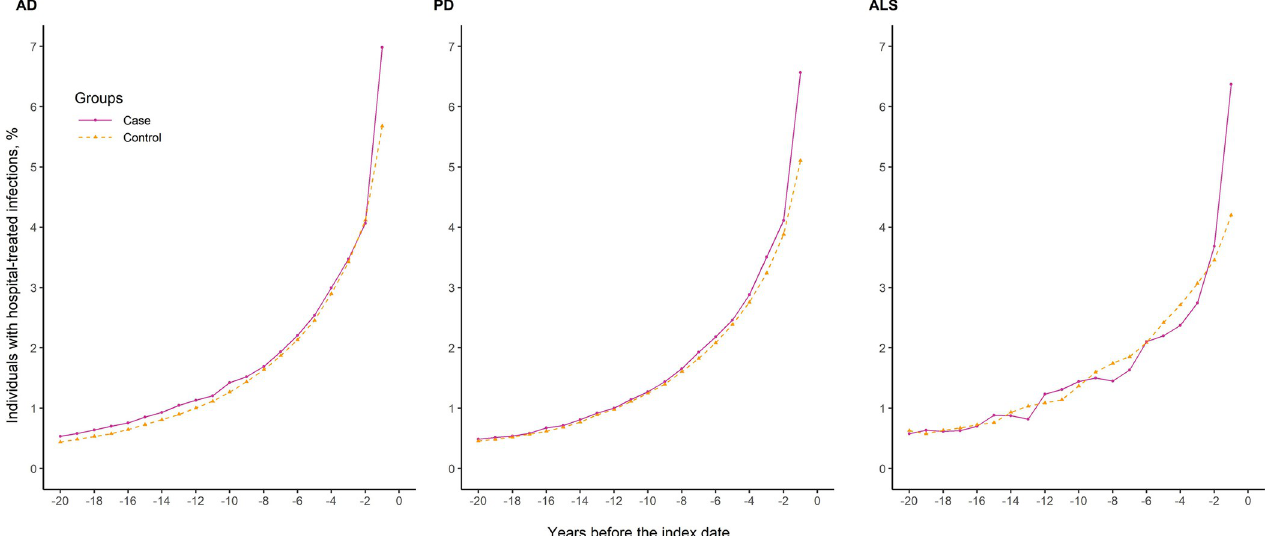
Fig 1. Percentage of individuals with hospital-treated infections among patients with neurodegenerative diseases and their matched controls during the 20 years before the index date. AD, Alzheimer’s disease; ALS, amyotrophic lateral sclerosis; PD, Parkinson’s disease.